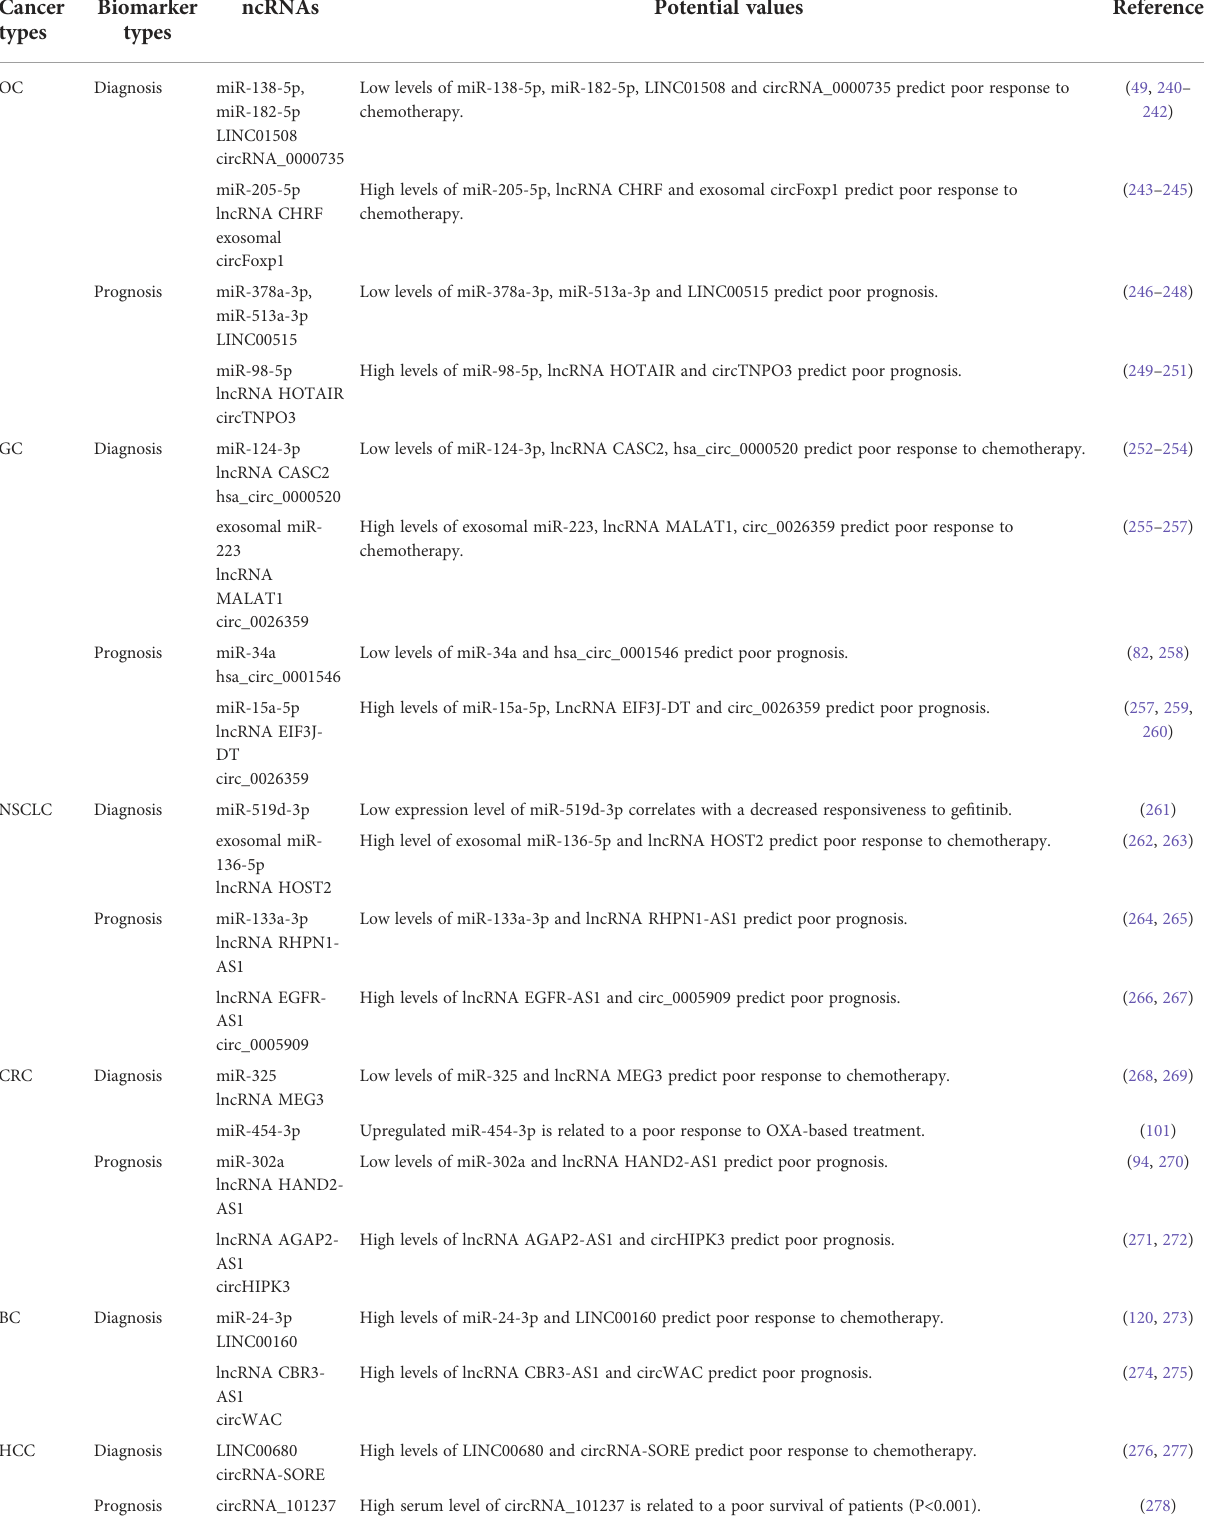
TABLE 2 NcRNAs as biomarkers diagnostic and prognostic in cancers drug